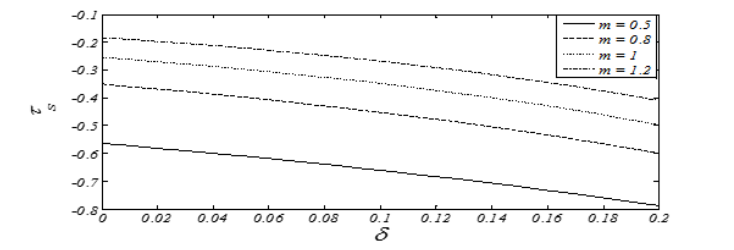
Fig. 14 Shear stress at stenotic throat for F=0.2.